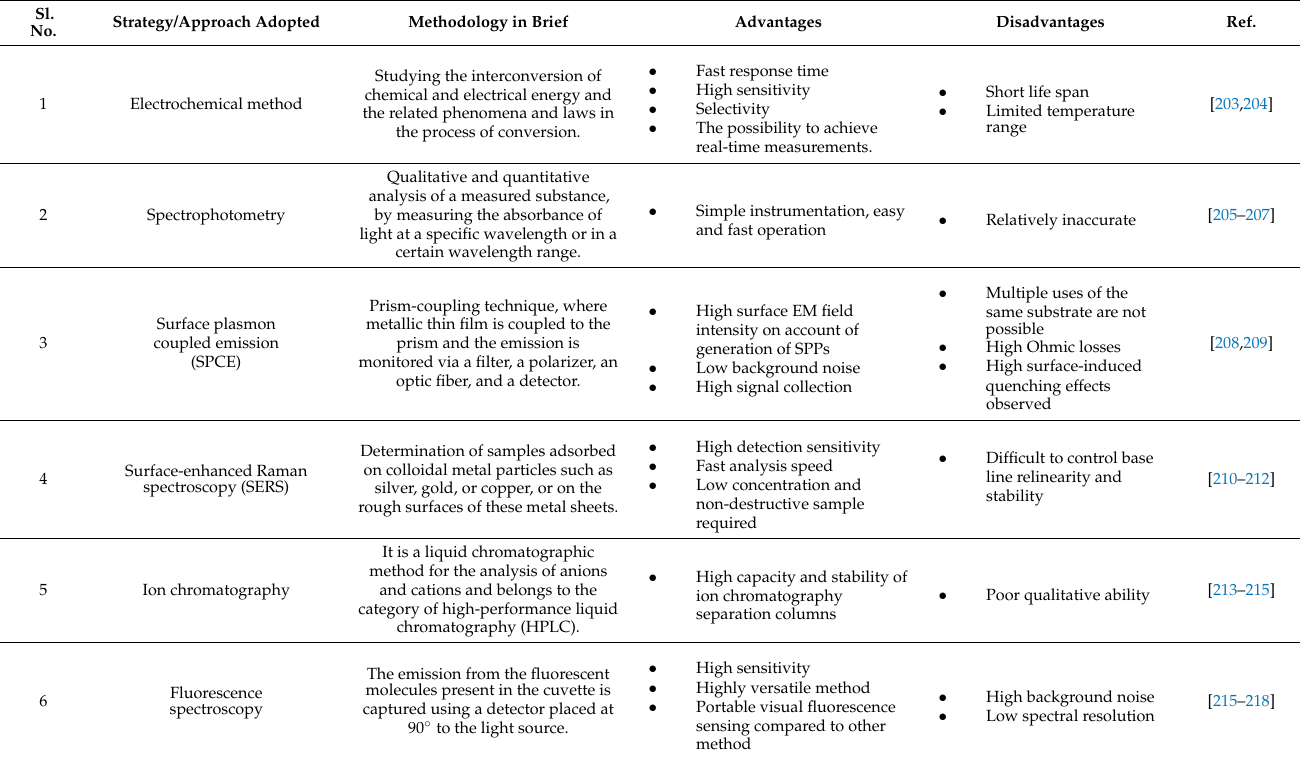
Table 4. Summary table of the comparison of the performance of the recent techniques/strategies developed for biosensing with fluorescence spectroscopy, presented along with their advantages and